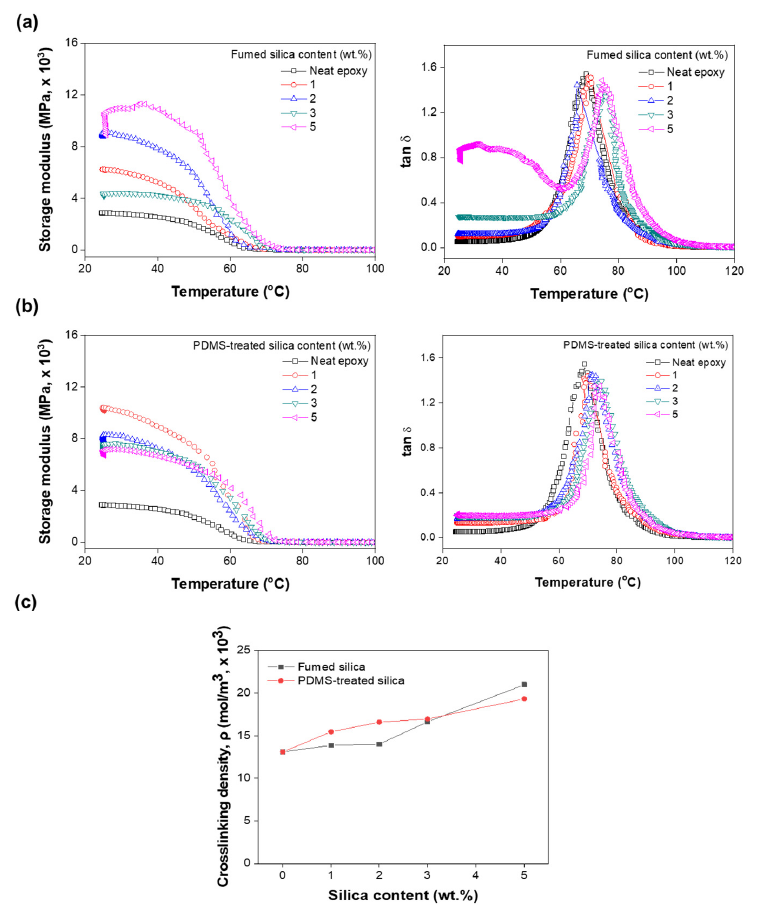
Figure 5. Variations in the storage modulus and tan δ values of the epoxy composites as functions of ( a ) fumed silica and ( b ) PDMS-treated fumed silica contents. ( c ) Crosslinking densities of epoxy/fumed silica and epoxy/PDMS-treated silica composites with silica content.